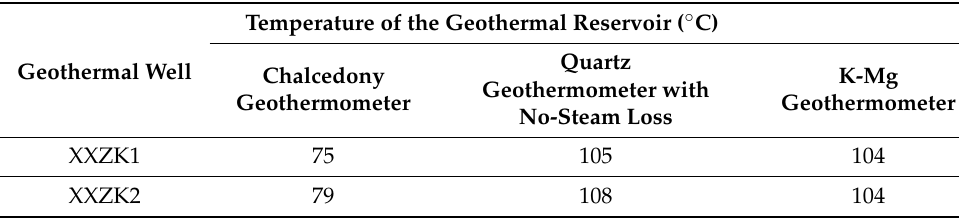
Table 3. Temperatures of the geothermal reservoir estimated using SiO 2 geothermometers and the K-Mg geothermometer.